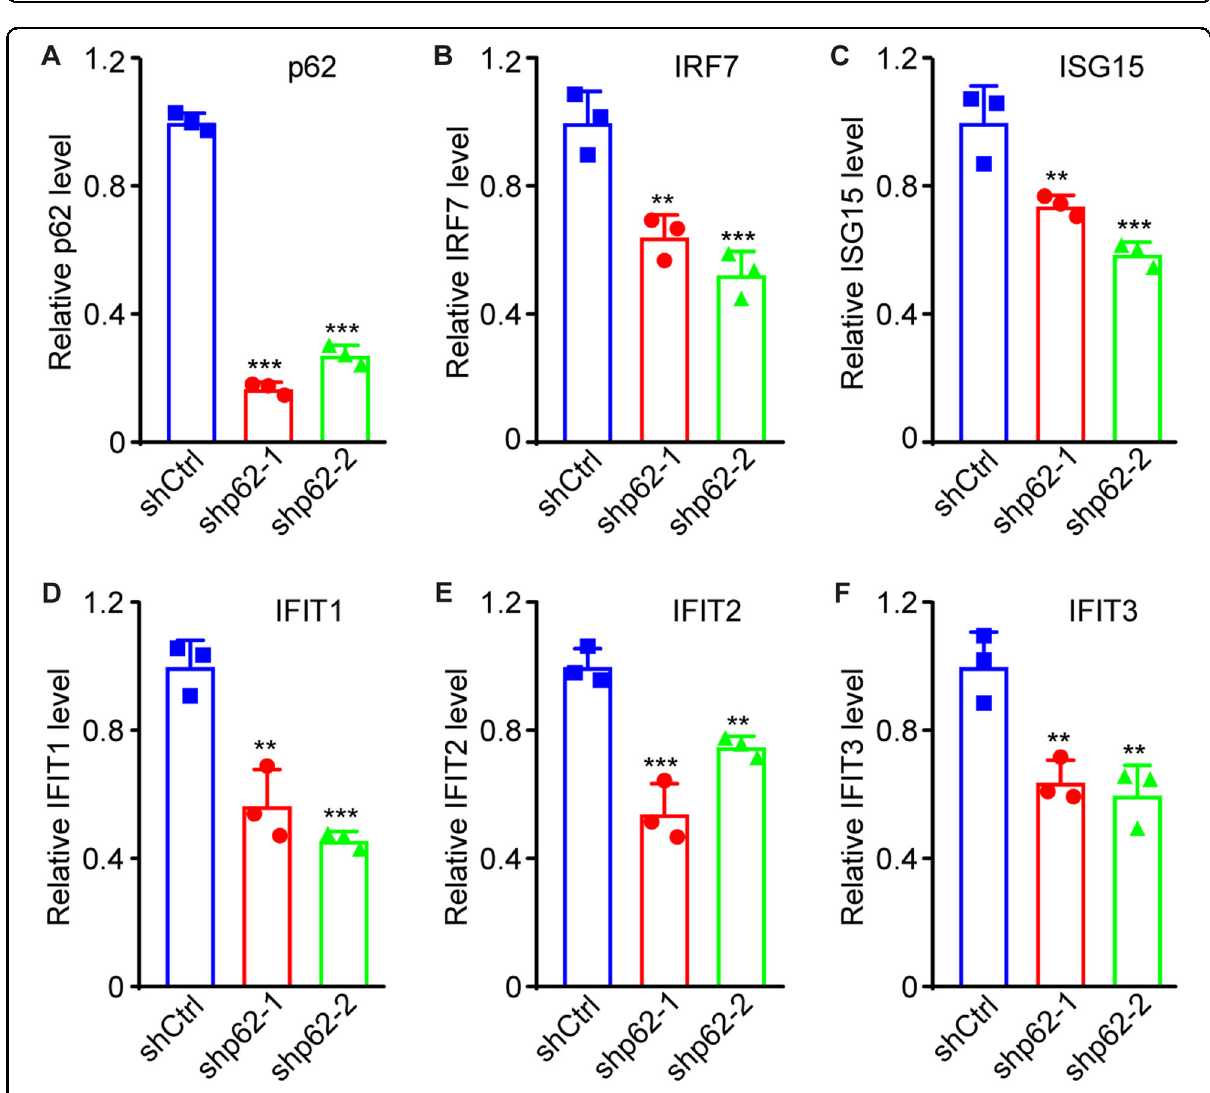
Fig. 7 Knockdown of p62 reduces the expression of innate immune-related genes during KSHV primary infection. A – F HUVEC with p62 knockdown were infected with KSHV for 48 h. Cells were collected for RNA extraction and examined for the expression of p62 ( A ), IRF7 ( B ), ISG15 ( C ), IFIT1 ( D ), IFIT2 ( E ), and IFIT3 ( F ) by RT-qPCR. *, **, and *** indicate P values of < 0.05, < 0.01, and < 0.001, respectively; NS not signi fi